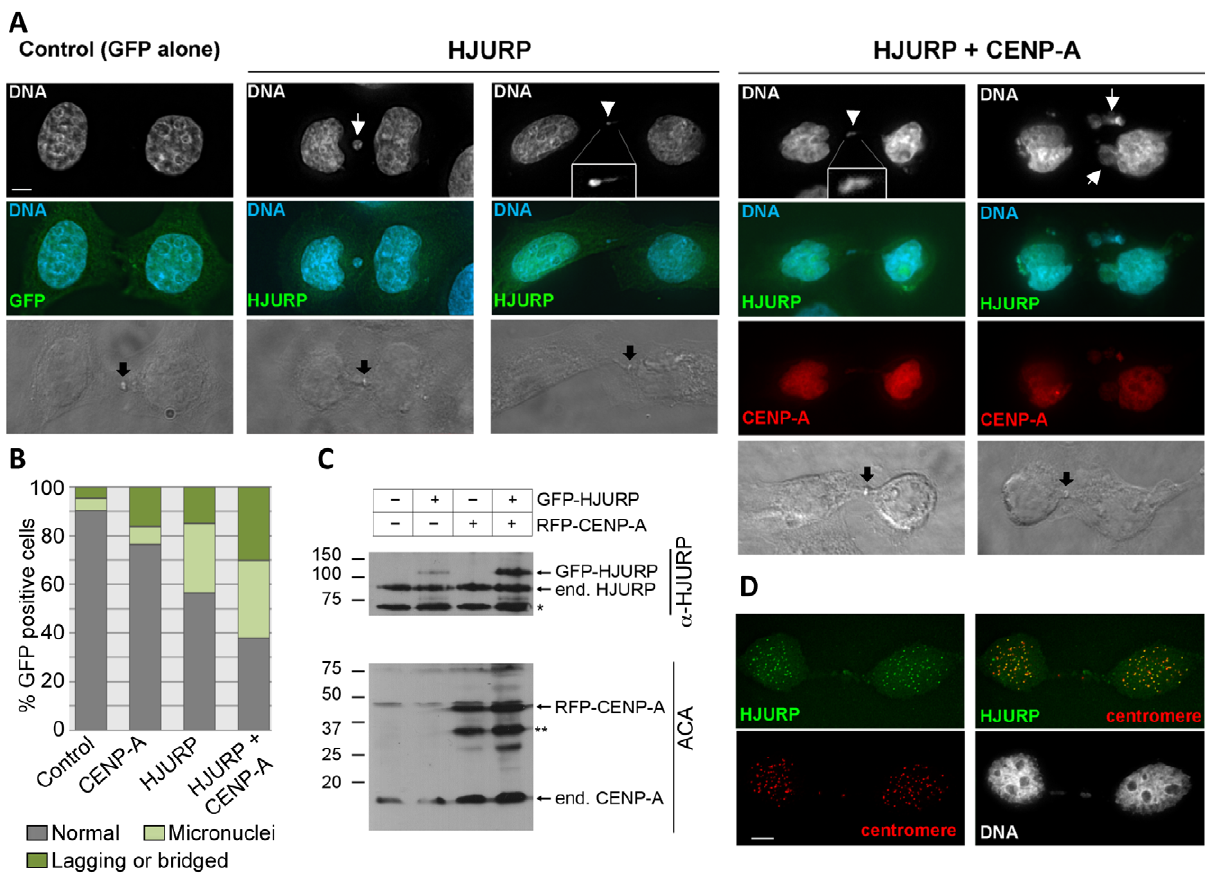
Figure 7. Chromosome segregation errors in human cells over-expressing of HJURP and CENP-A. (A) HeLa cells were transient transfected with GFP-HJURP and/or RFP-CENP-A . Cells were blocked in thymidine for 20 hours and released for 12 hours to enrich for cells that have recently undergone mitosis (early G1). Cells in early G1 were identified by the presence of a midbody (black arrow). DNA was stained with DAPI. Micronuclei (white arrow), chromosome bridges or lagging chromosomes (white arrowhead) were evident in cells over-expressing HJURP , and both HJURP and CENP-A . (B) The degree of micronuclei and lagging or bridged chromosomes were quantified in cell transiently over-expressing RFP-CENP-A , GFP- HJURP or RFP-CENP-A and GFP-HJURP . While individual over-expression of CENP-A or HJURP yielded rates of chromosome abnormalities greater than controls, the highest degree of micronuclei and lagging or bridged chromosomes was observed with co-overexpression of both CENP-A and HJURP . Values are the average from two independent experiments, . 100 cells per experiment. (C) Western blot showing expression of GFP-HJURP and RFP- CENP-A in HeLa cells. Asterisk represents non-specific bands. (D) Cells over-expressing GFP-HJURP were pre-extracted in 0.1% Triton prior to fixation. Centromeres were identified using anticentromere autosera. GFP-HJURP colocalizes with centromeres demonstrating that over-expressed HJURP is able to localize similar endogenous HJURP . Scale bar equals 5 micron.